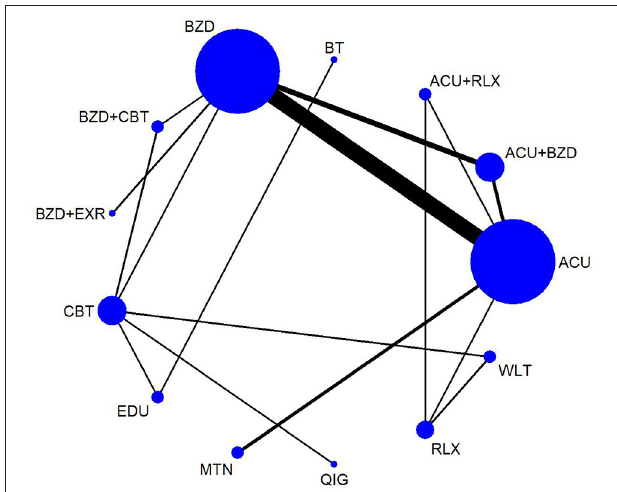
FIGURE 2 | Network map for PSQI total score. ACU, acupuncture; BT, behavioral treatment; BZD, benzodiazepines; CBT, cognitive behavioral therapy; EDU, sleep education; EXR, exercise; MTN, melatonin; QIG, qigong; RLX,